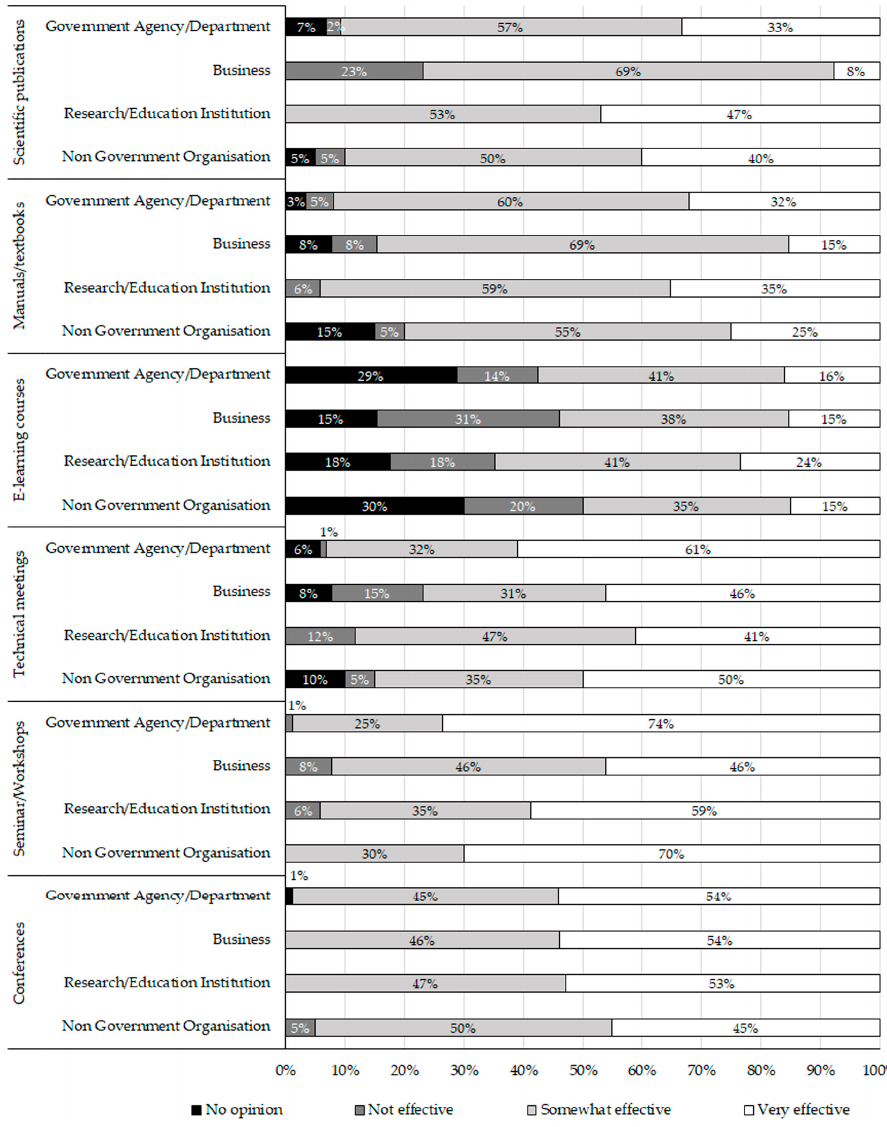
Figure 2. Evaluation of the effectiveness of different means of knowledge acquisition among categories of respondents with the percentages (%) of responses for each assessment scale point.